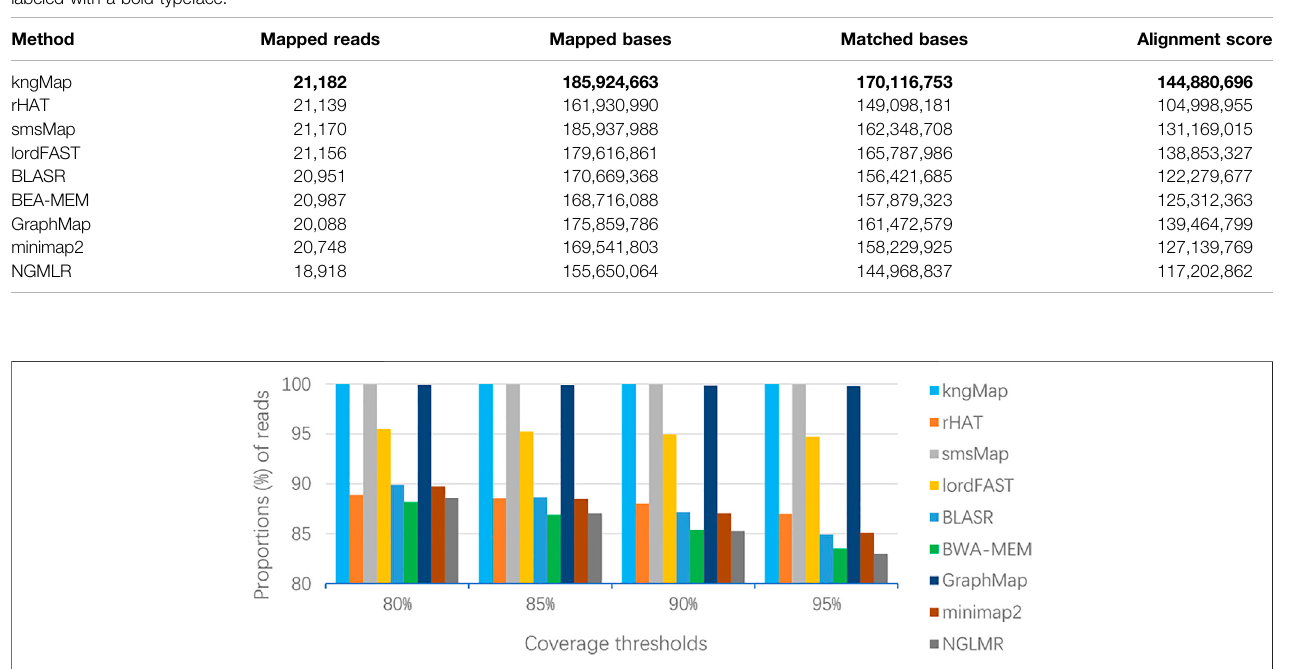
FIGURE 3 | Consecutiveness alignment of different methods on the A. thaliana dataset. The percentage values labeled on the horizontal axis are the thresholds of the proportion of covered bases, that is, c i ( i = 1,2,3,4), for considering if the alignment result for a read is consecutive. The vertical axis bars indicate the proportions of reads consecutively mapped by different mappers. kngMap always achieved 100% consecutive alignments with all thresholds, while GraphMap achieved 99.91%, 99.88%, 99.84%, and 99.77% consecutive alignment at 80%, 85%, 90%, and 95% coverage thresholds, respectively. Therefore, kngMap is superior to GraphMap in providing better consecutive alignments. Each bar also corresponds to a value line in Supplementary Table S10 .